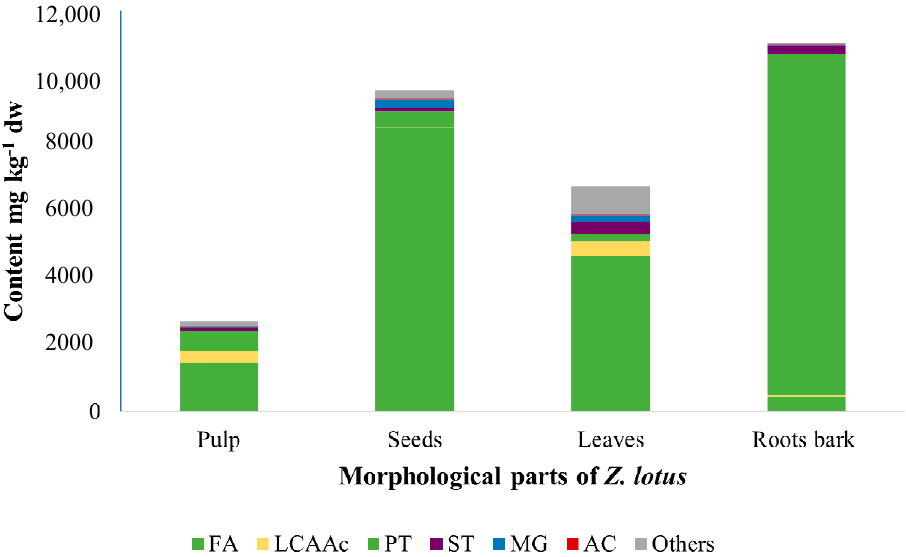
Figure 2. Major families of lipophilic compounds identified by GC–MS in dichloromethane extracts of Z. lotus . Abbreviations: AC, aromatic compounds; FA, fatty acids; LCAAc, long-chain aliphatic alcohols; LCAAd, long-chain aliphatic aldehydes; MG, monoglycerides; PT, pentacyclic triterpenic compounds; ST, sterols.